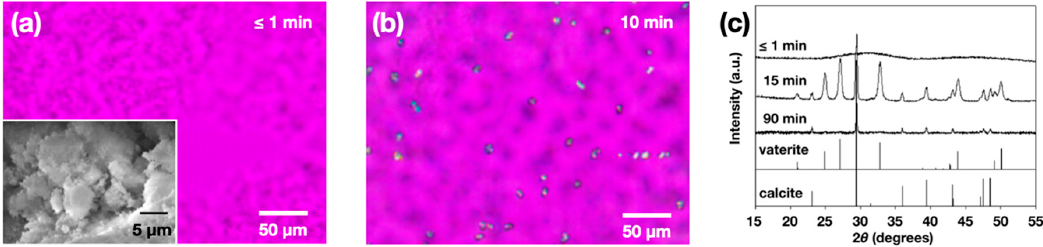
Figure 1. Optical micrographs under cross polarization right after ACC formation ( a ) and after 10 min ( b ); a SEM image of ACC before transformation was shown as an inset of ( a ). XRD patterns ( c ) of ACC and its transformed phases with time were shown along with the reference peaks of vaterite and calcite [28].